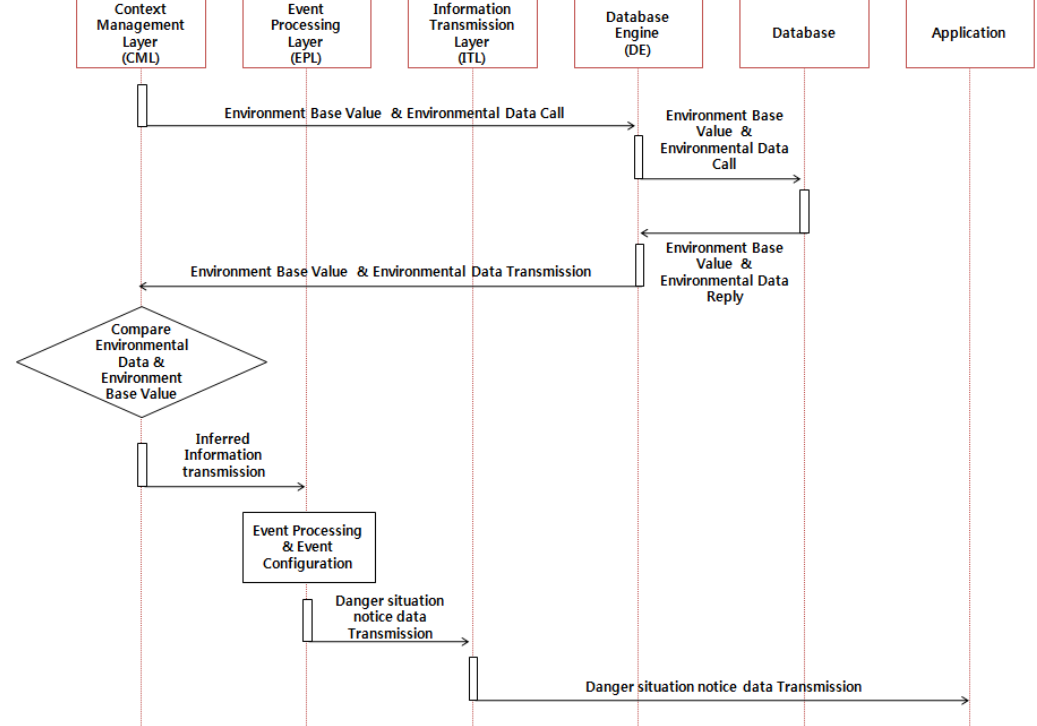
Figure 8. Operation process of Danger Situation Notice Service.